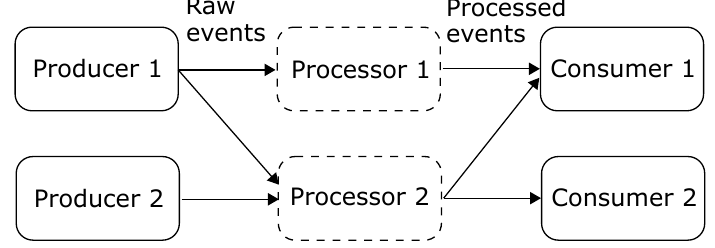
Figure 1. The event-streaming graph from producers towards the